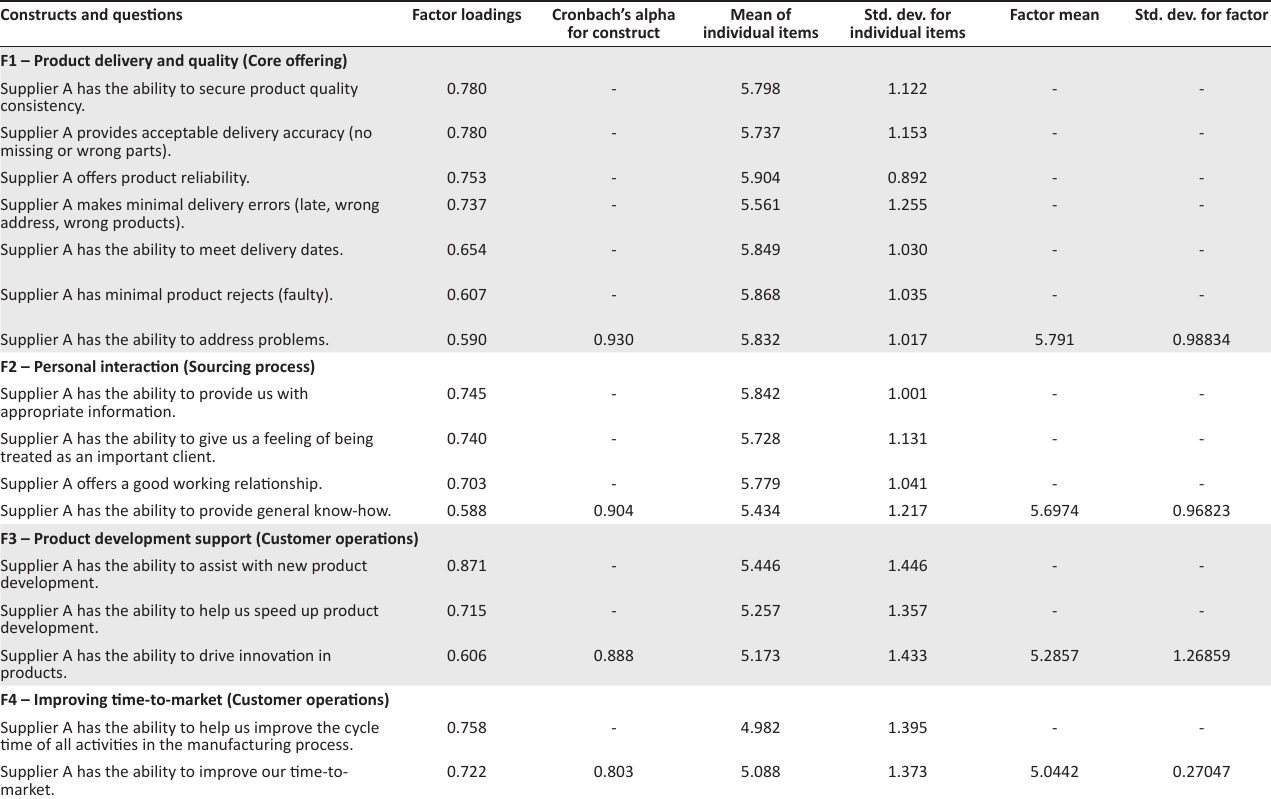
TABLE 4: Factors (F1, F2, F3, F4). Constructs and